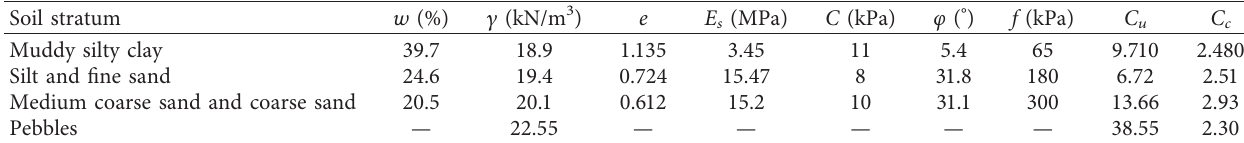
Figure 2: Longitudinal soil profile along the tunnel. Table 1: Basic physical and mechanical properties of the soils.